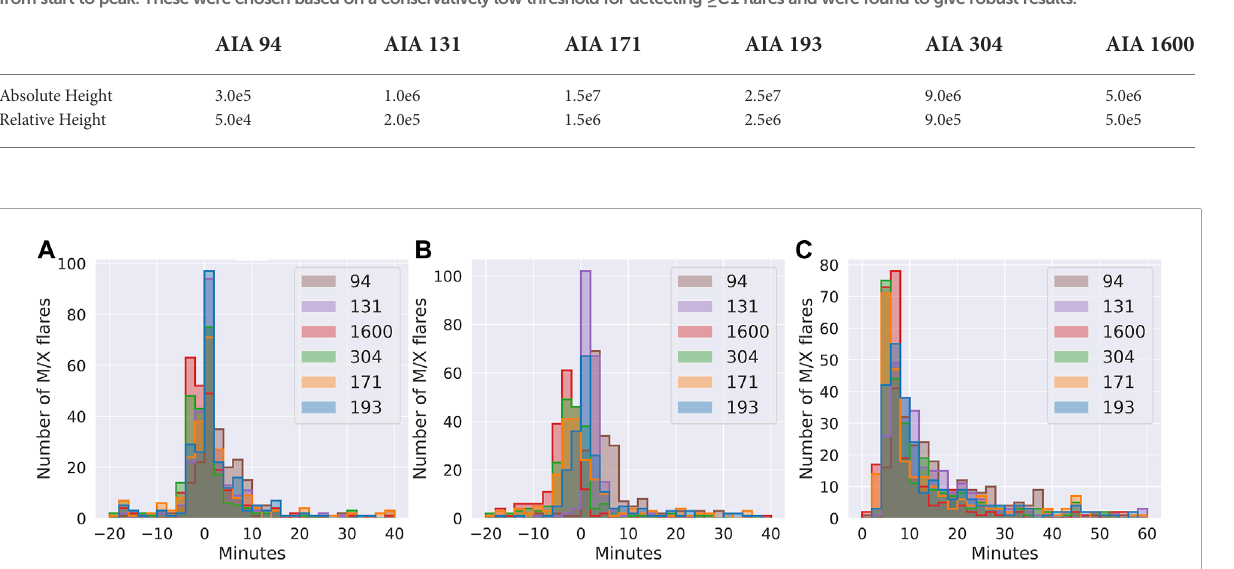
FIGURE 2 Comparison of start and peak times for flaring as measured in AIA. (A) , discrepancy in minutes between AIA flare start times and GOES flare start times. (B) , discrepancy in minutes between AIA flare peak times and GOES flare peak times (note that the GOES flare catalog does not contain peak times for flares after 2017/06/30 so we only include available data). (C) , time between flare start and peak for AIA flares.